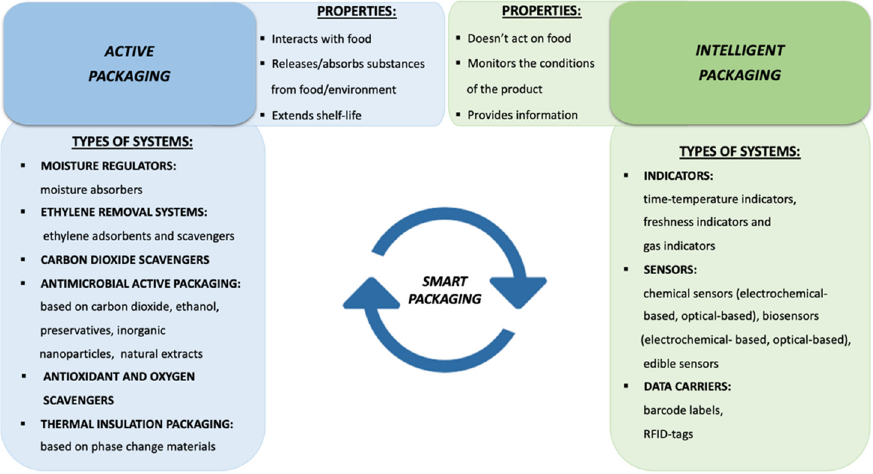
Figure 1. Active and Intelligent packaging classification and their main